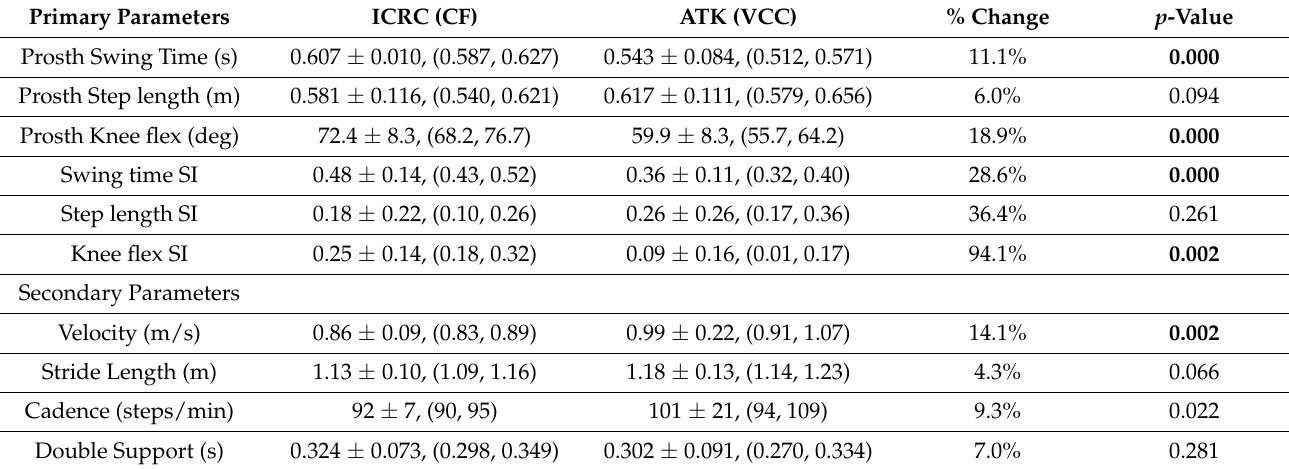
Table 2. Gait parameters for ICRC CF and ATK VCC for normal walking